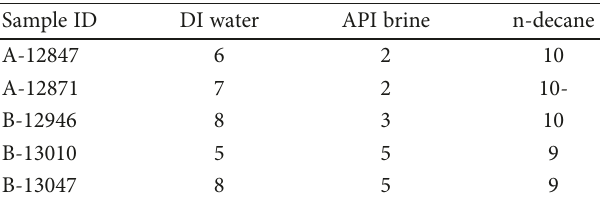
Figure 6: Photos of droplet wettability tests. Some shining spots are from the lighting e ff ects. Table 3: Wetting characteristics of the Springer shale samples from droplet wettability tests. A qualitative number is assigned for the spreading behavior over 30 seconds: number one designates no spreading at all, while number 10 represents a perfect spreading of the fl uid on the sample